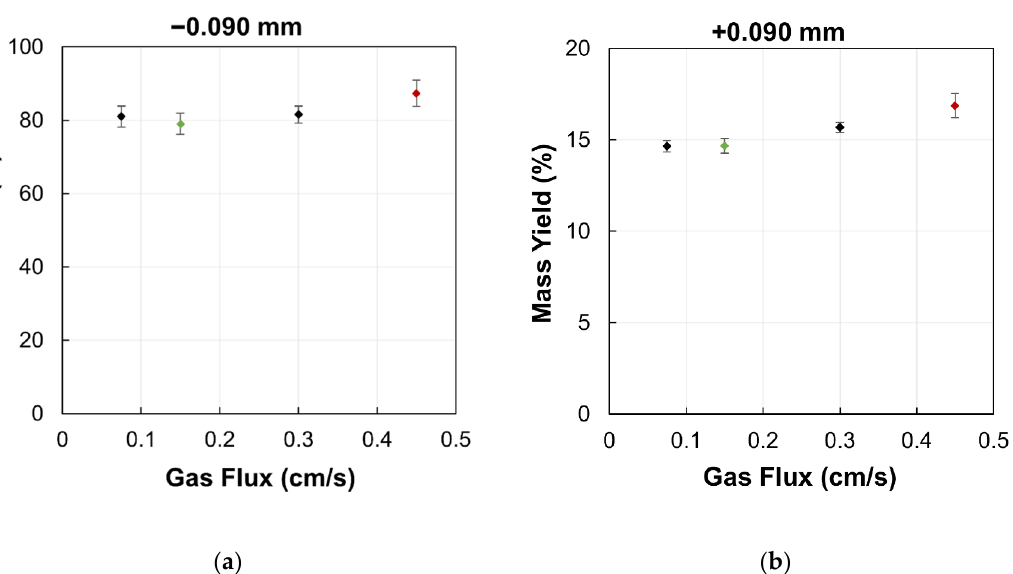
Figure 7. Mass yield-to-overflow product as a function of gas flux for the particles passing through a screen with sieve aperture of 0.090 mm ( a ) and +0.090 mm particles ( b ) with the best (green) and poorest (red) performances highlighted. Error bars show 95% confidence.